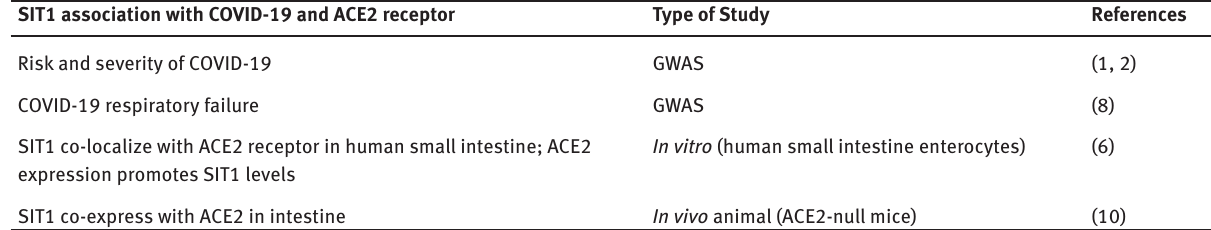
Table 1: Relevant publications dealing with association of SLC6A20 / SIT1 with COVID-19 and/or ACE2 receptor for SARS-CoV-2. SIT1 association with COVID-19 and ACE2 receptor Type of